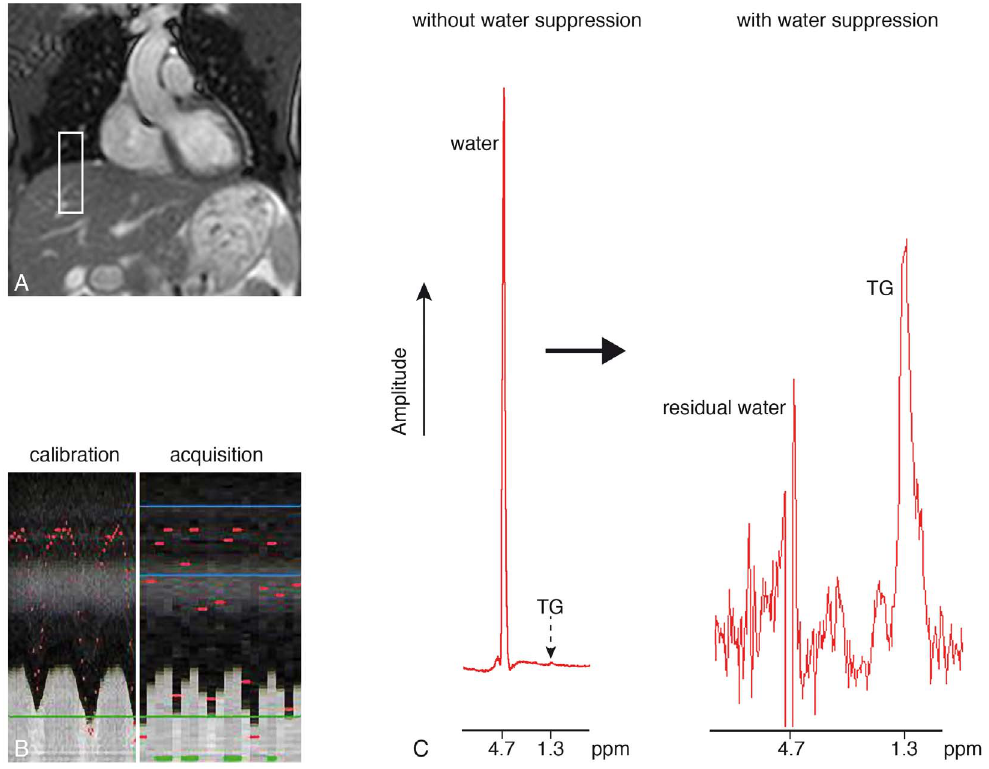
Figure 2. Planning of the respiratory navigator. The navigator pencil beam is positioned on the right hemidiaphragm (panel A). Panel B shows the calibration phase with a high temporal resolution, in which the lung-liver interface is detected during free breathing, as well as the acquisition phase showing the accepted measurements in the predefined end-expiratory window (lower temporal resolution). Panel C shows a typical non- suppressed (left) and a suppressed (right) localized renal proton spectrum, obtained using respiratory motion compensation and gating.